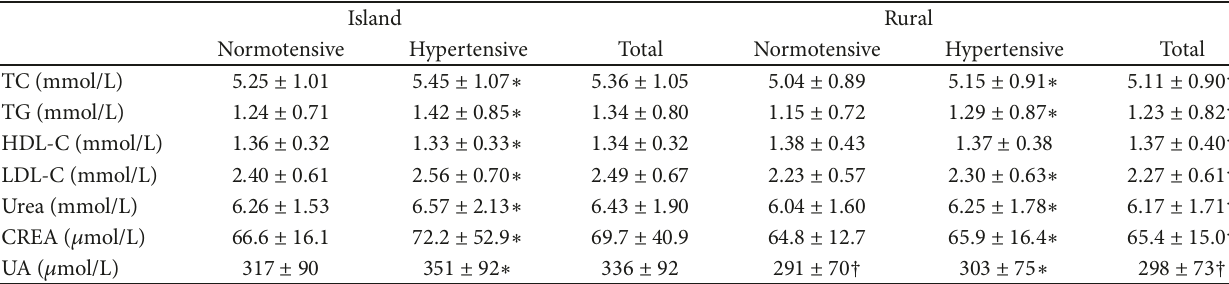
Table 4: The blood biochemical parameters in island and rural residents.